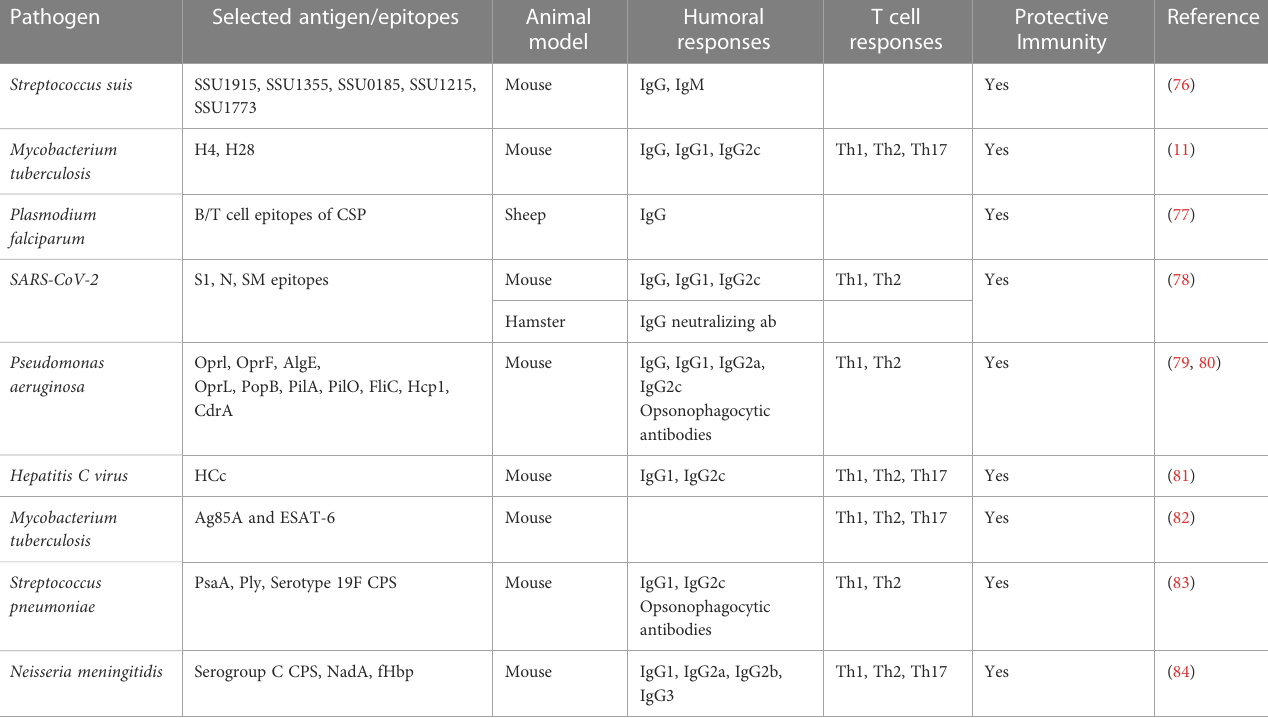
TABLE 2 PHA particle vaccines with protective immunity against various infectious pathogens.